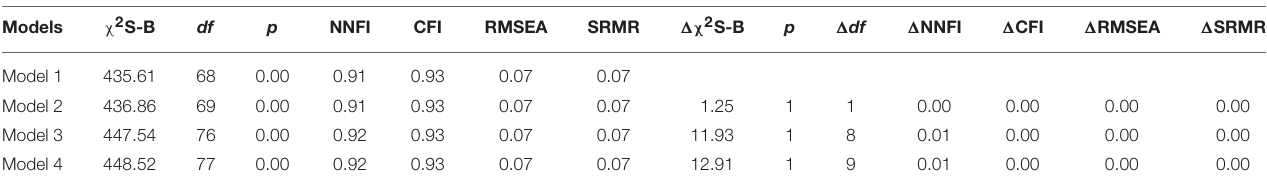
TABLE 3 | ERQ Multi-group analysis in students under 15 years and students aged 15 and older: metric and residual invariance. Models χ 2 S-B